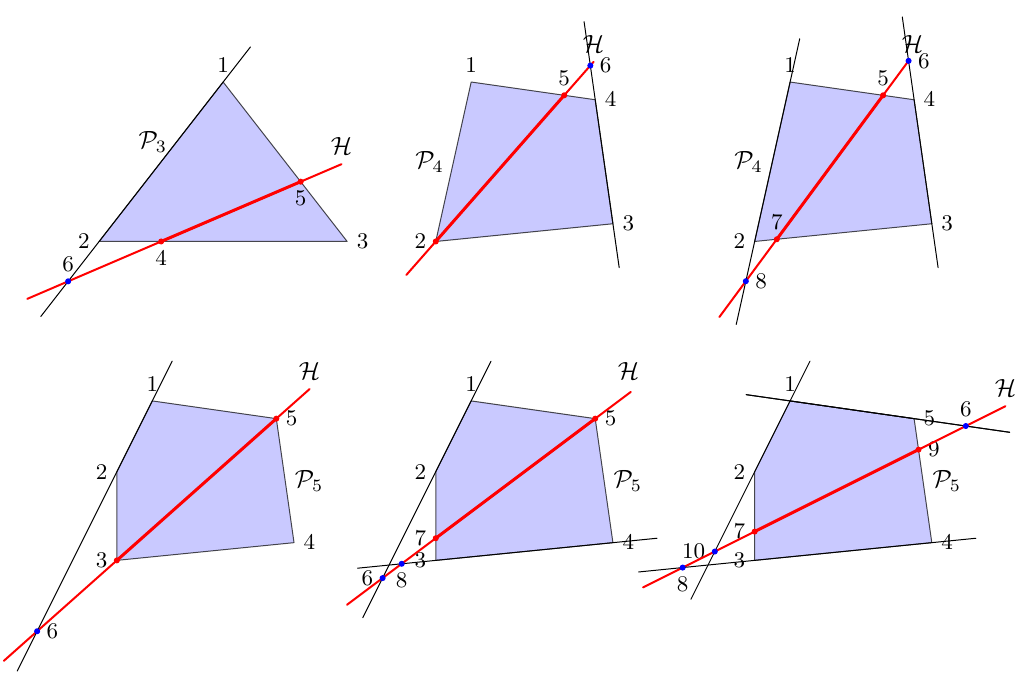
Figure 2 . Examples of projective polytopes ( P 2 ; P n ) intersected by a hyperplane on its facets both inside and outside P n . For polygons P n (cid:21) 5 the latter is the only choice for an hyperplane H such that H T P n (cid:21) 5 6 = ?